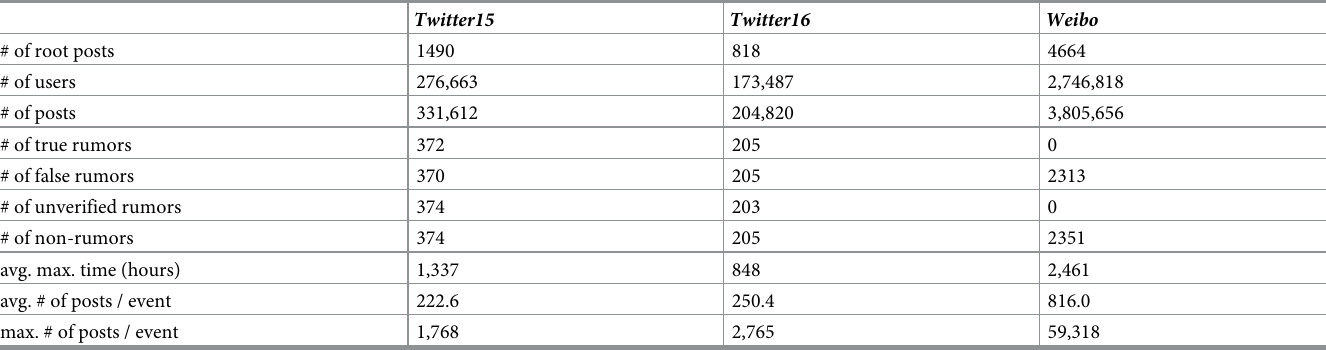
Table 1. The statistics of the rumor detection